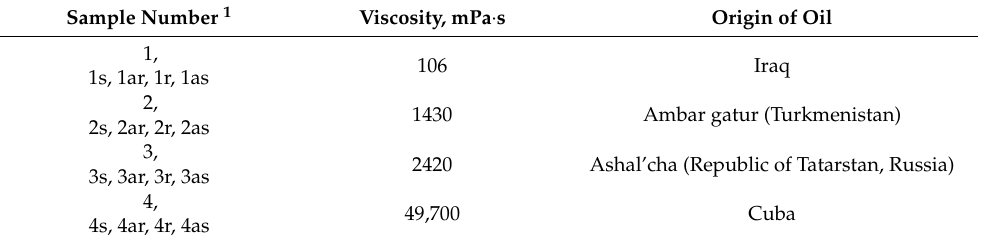
Table 1. Studied oil samples and the viscosities of the initial oil species.